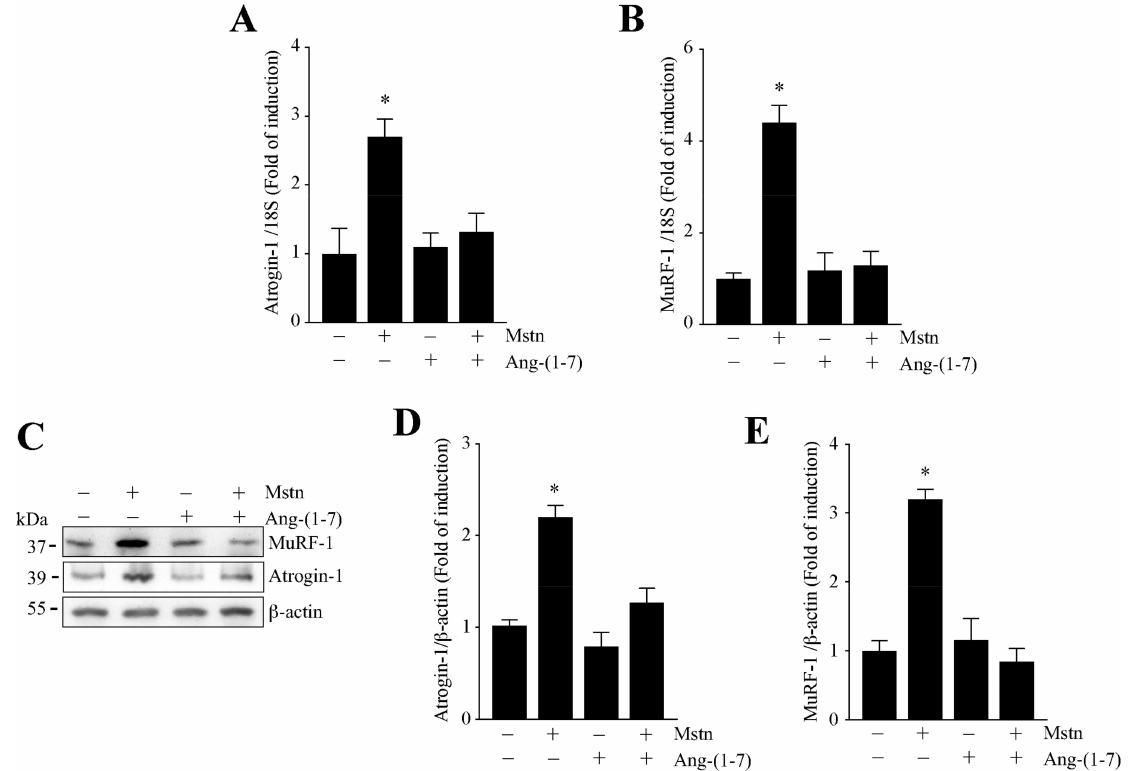
Figure 3. Ang-(1-7) avoided the myostatin-dependent induction of atrogin-1 and MuRF-1 in the myotubes. The C 2 C 12 cells differentiated for five days were pretreated or not with Ang-(1-7) (10 nM) for 1 h, and further with myostatin (Mstn, 1 µ g / mL) for 12 or 24 h. The mRNA levels of atrogin-1 ( A ) and MuRF-1 ( B ) were determined by RT-qPCR. ( C ) The protein levels of atrogin-1 and MuRF-1 were detected by Western Blot analysis. β -actin was used as the loading control. The molecular weights are shown in kDa. Quantitative analysis of atrogin-1 ( D ) and MuRF-1 ( E ) levels with values normalized to β -actin. All of the values correspond to the mean ± SD from three independent experiments ( n = 3; * p < 0.05 vs. control without treatment).